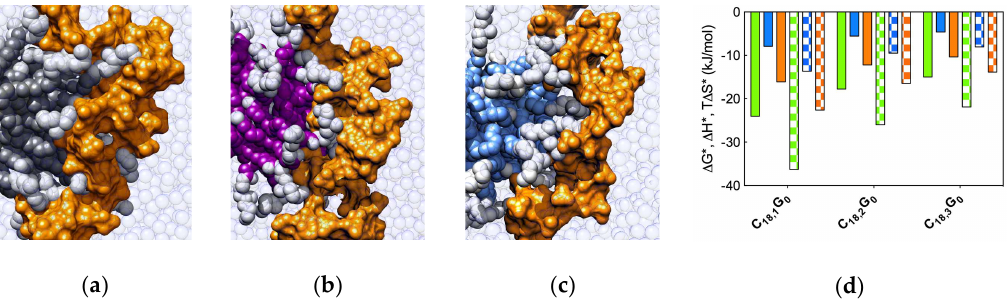
Figure 13. Zoomed view of the images extracted from the equilibrated portion of the MD simulations for self-assembled dendrimers C 18,1 G 0 ( a ), C 18,2 G 0 ( b ), and C 18,3 G 0 ( c ) in complex with heparin. In all panel, micelles are colored as in Figure 12b, heparin is portrayed by its orange van der Waals surface, while water, ions and counterions are shown as transparent spheres. ( d ) Per-residue effective free energy (∆G* = ∆G bind,eff /N eff , orange), enthalpy (∆H* = ∆H bind,eff /N eff , green) and entropy (T∆S* = ∆S bind,eff /N eff , blue) of binding for the three self-assembled dendrimers in panels ( a – c ) (solid bars) and for the heparin sugars complexed with each of these three self-assembled dendrimers (patterned bars). Adapted from [25], with permission of John Wiley & Sons.